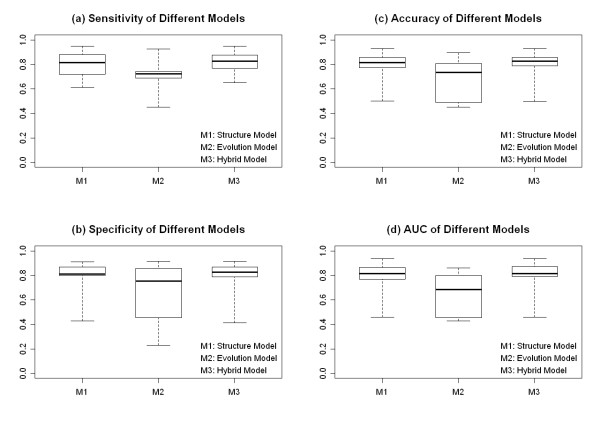
Performance comparison of different models for 17 TF-TFBSs (without PWM information). Panel(a)-(d): boxplot of 3 models (the structure model, the evolution model, and the hybrid model) for sensitivity, specificity, accuracy and AUC measurement. For a boxplot, the 5 whiskers from bottom to top denote the 5th, 25th, 50th, 75th, and 95th percentile respectively.